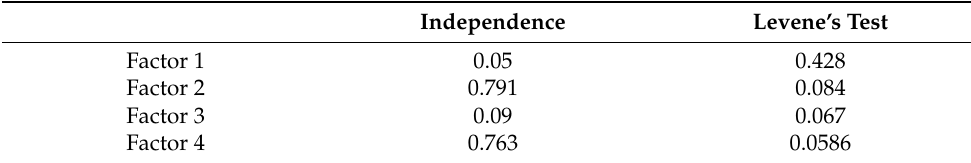
Table 4. p -values ANOVA of the factor